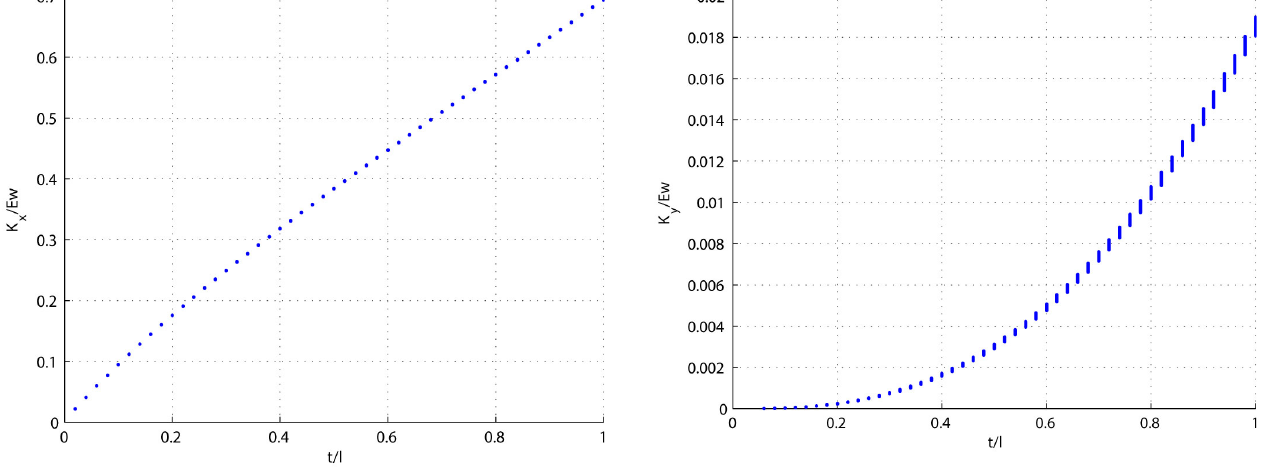
Figure 7. Sti ff ness in x direction dimensionless design parameter.